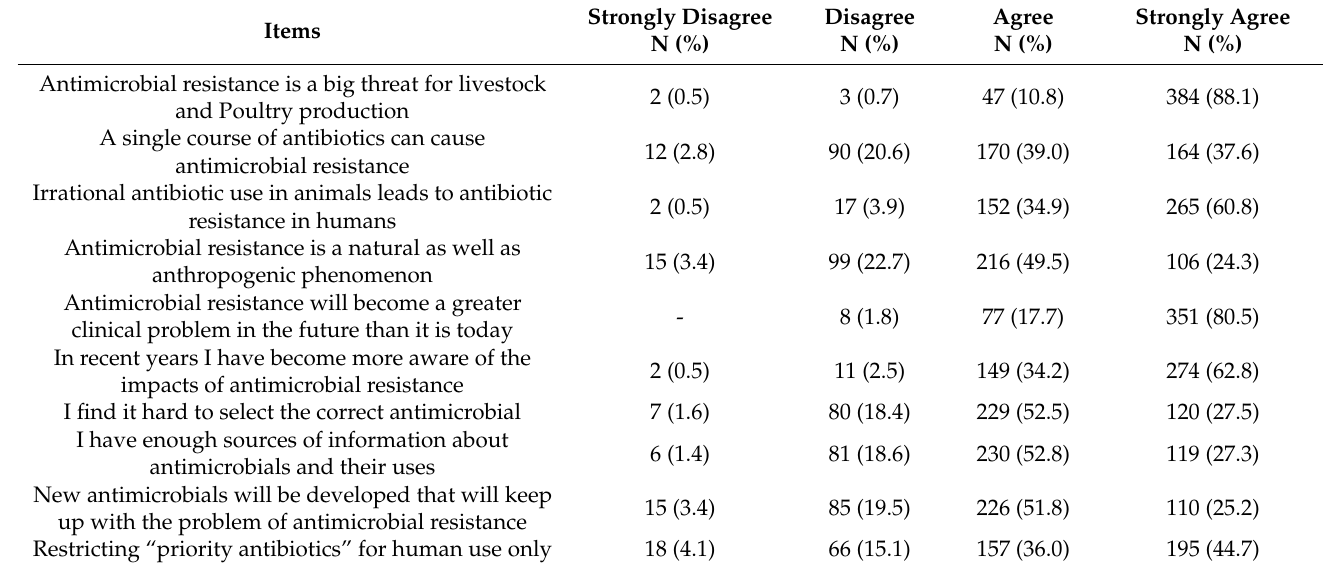
Table 3. Attitudes of veterinarians on AMU and